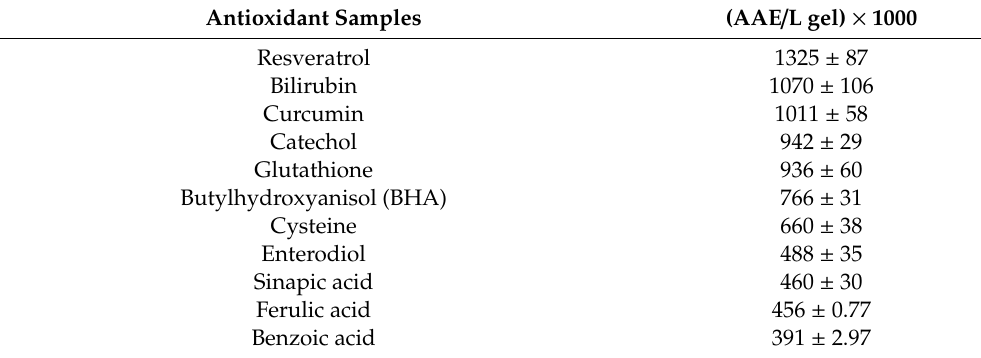
Table 1. PAOT-Score ® expressed as (AAE / L gel) × 1000) of pure antioxidants at a final concentration of 1 mM and POT-Score ® expressed as (SAE / L gel) × 1000) of six systems (0.1 mM) producing oxidants after 10 min of contact with ECG conductive gel containing the oxidized / reduced mediator M and connected to reference and working microelectrodes. PAOT-Score ® of ascorbic acid (AA) = 2699 ± 291; POT-Score ® of superoxide anion (SA) produced as described by Diaz-Uribe et al. [23] = 217 ± 20. Antioxidant